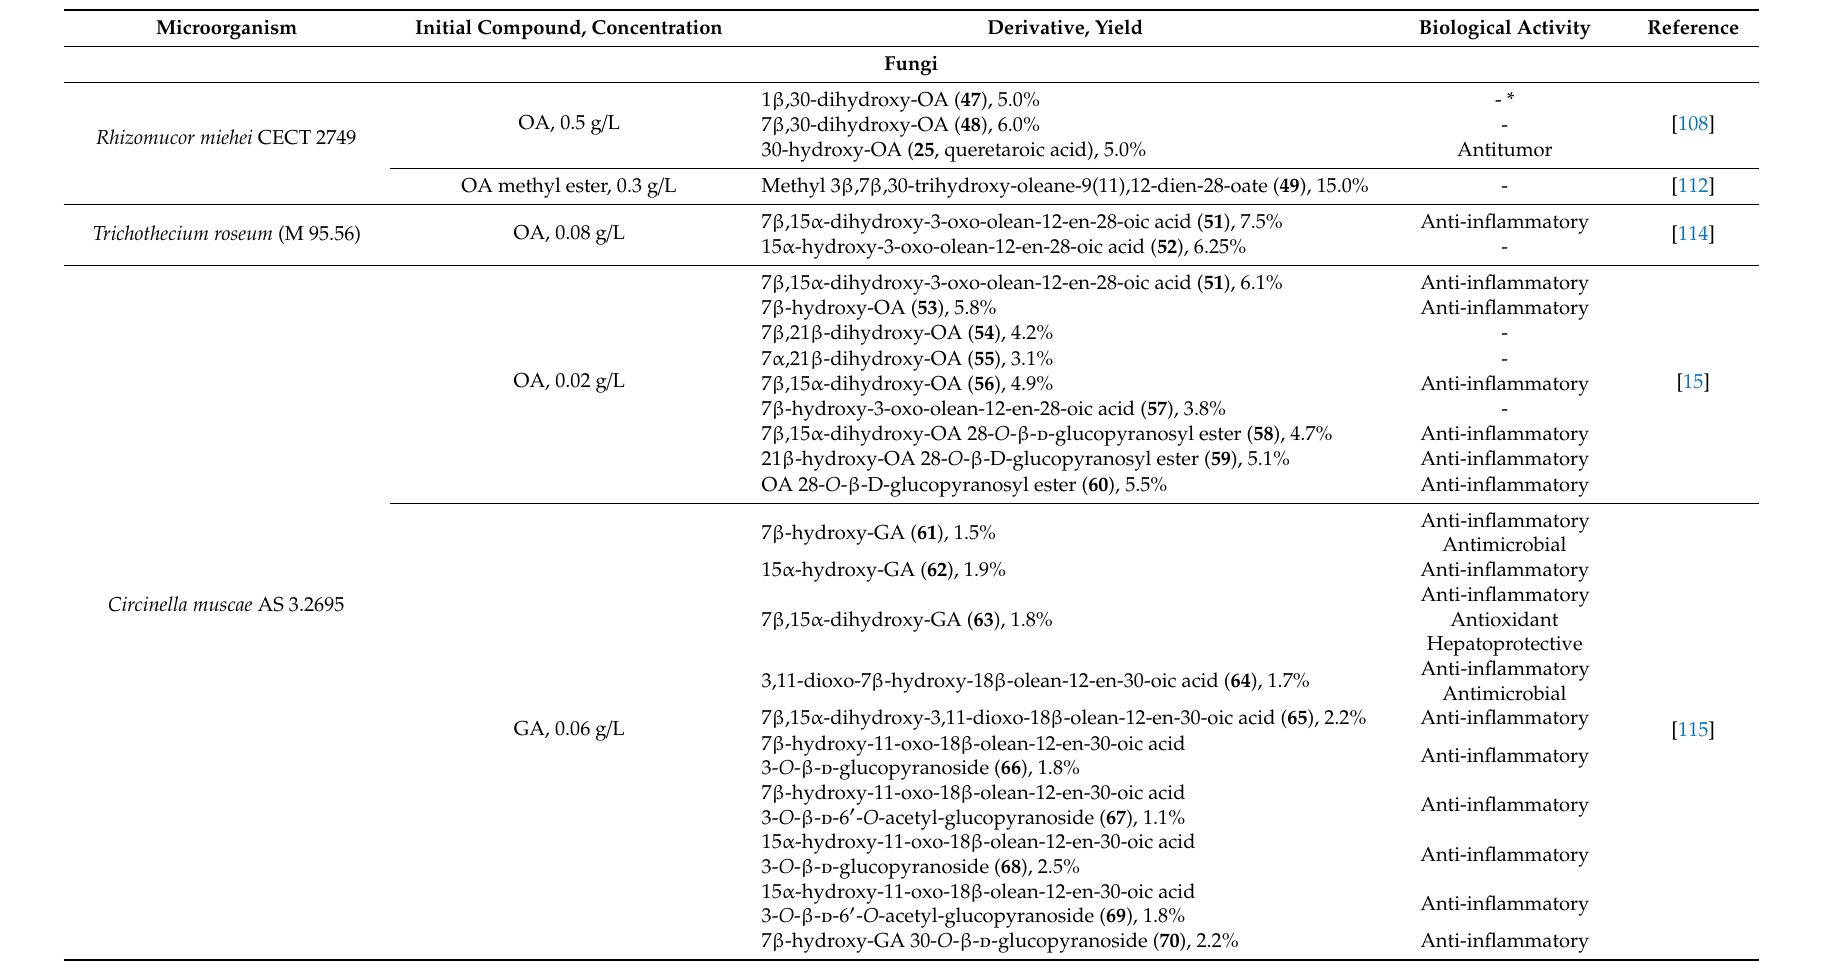
Table 3. Biological activity of pentacyclic triterpenoid products derived by